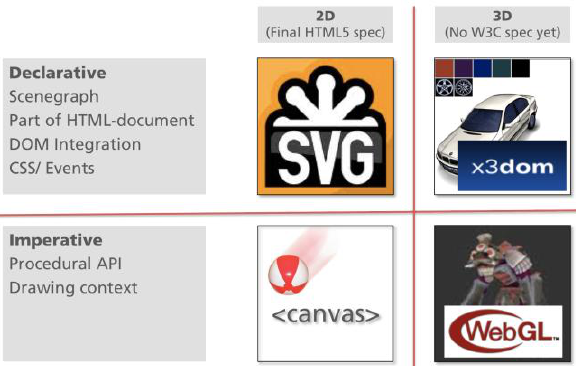
Figure 2. SVG, Canvas, WebGL and X3DOM relation.